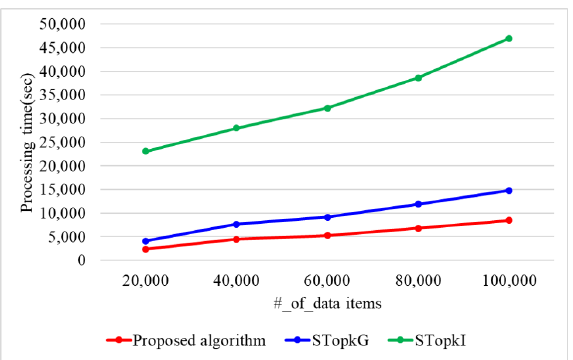
Figure 9. Processing time with a varying number of data items.